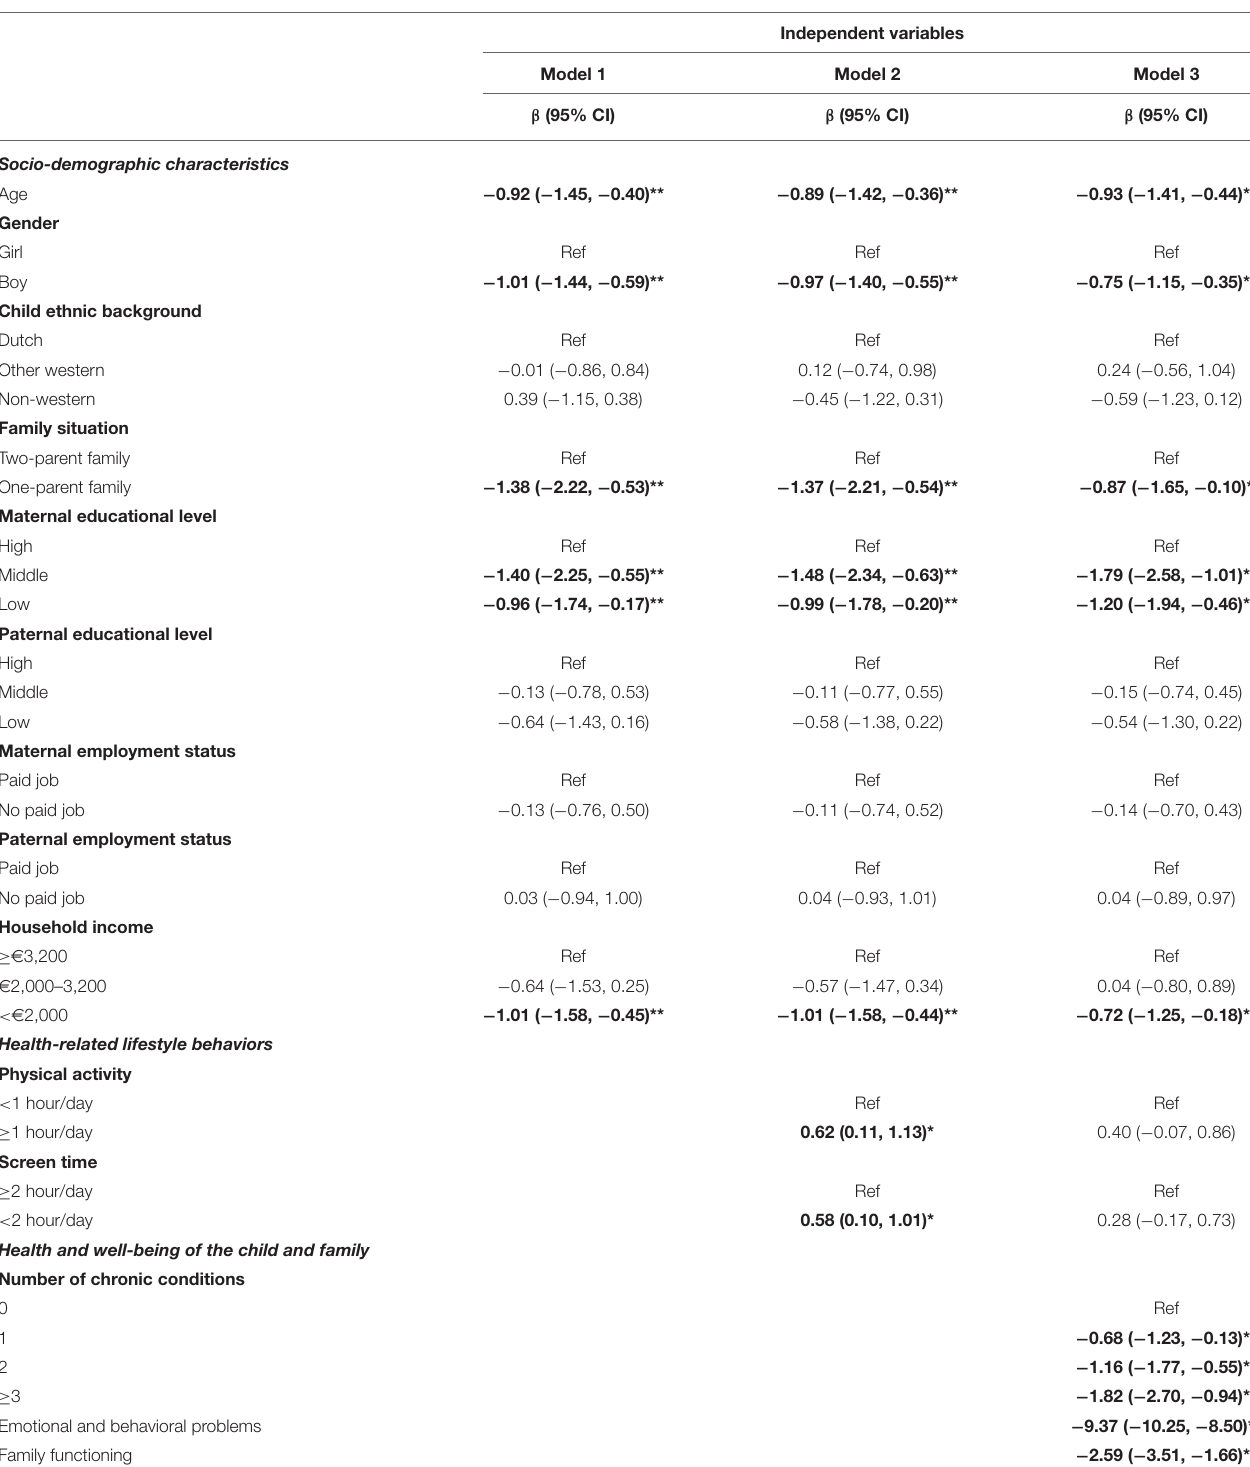
TABLE 3 | Multivariate analyses of socio-demographic characteristics, health-related lifestyle behaviors, and health and well-being of the child and family with psychosocial summary score